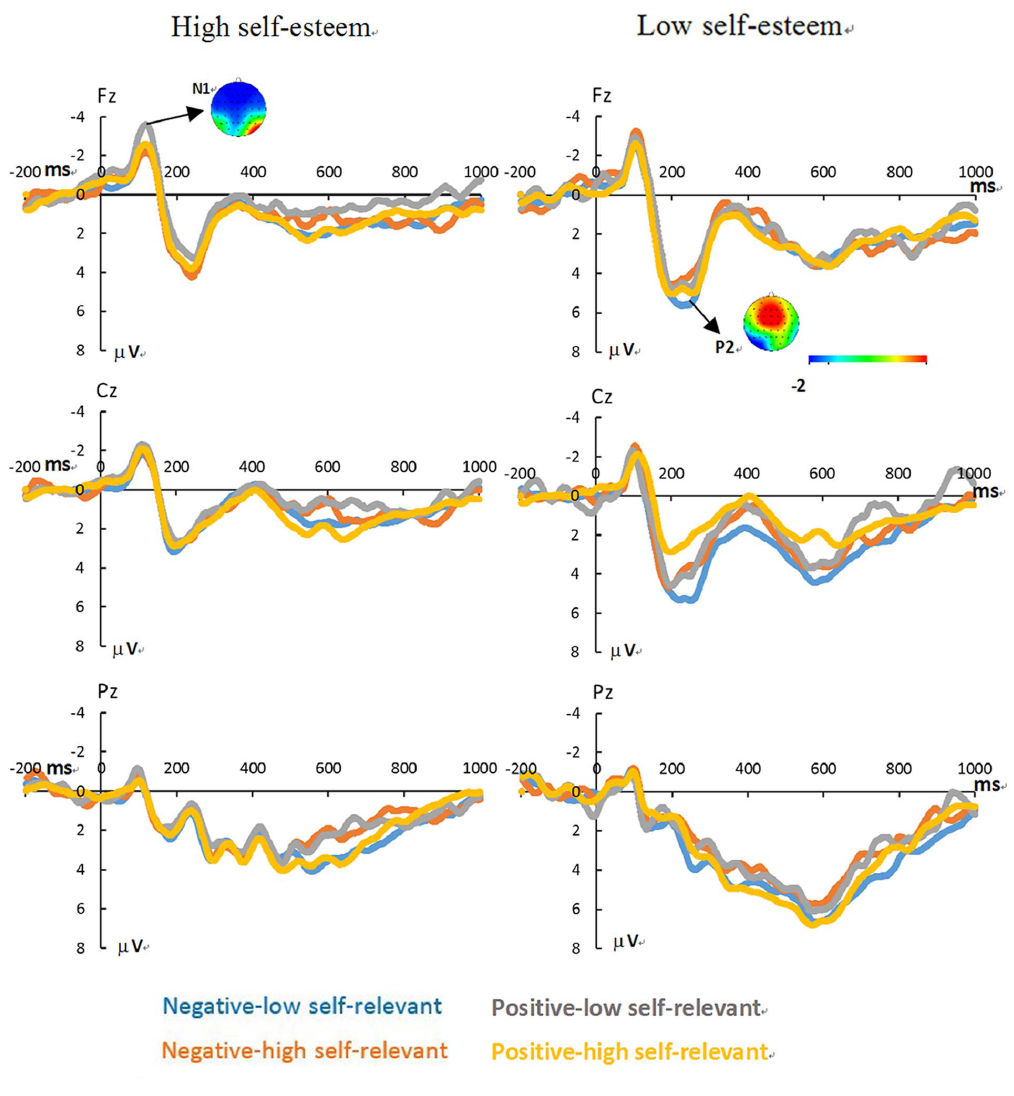
Figure 1. The grand average ERPs for the negative-low self-relevant processing (blue line), the negative-high self-relevant processing (red line), the positive-low self-relevant processing (grey line), and the positive-high self-relevant processing (yellow line) in the low self-esteem group and in the high self-esteem group. The topographic maps of the frontal N1 component in the positive-low self-relevant condition and the frontal P2 component in the negative-low self-relevant condition at electrode of Fz are also shown in Figure 1.